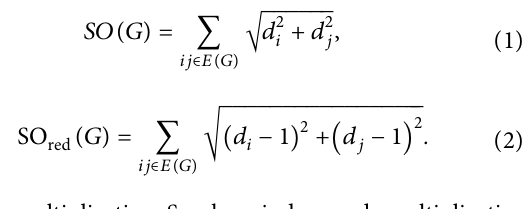
Figure 1: Unit cell (bismuth triiodide).